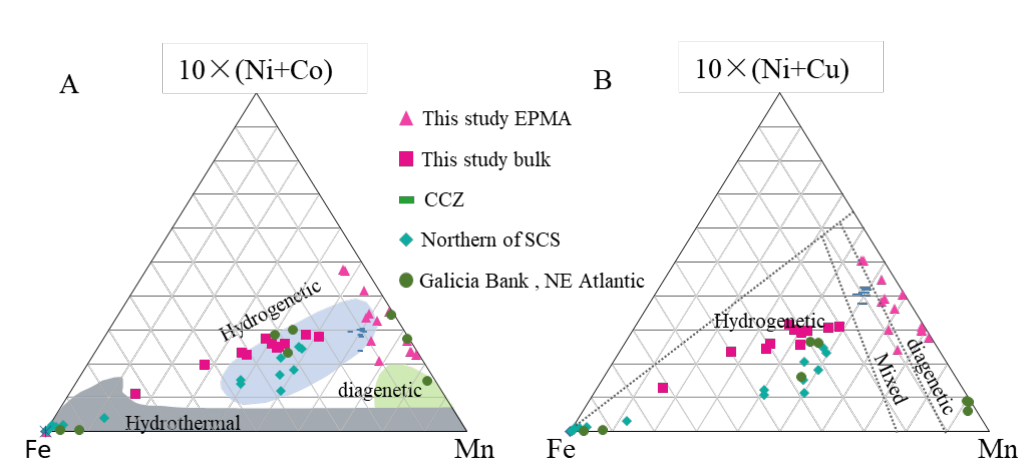
Figure 10. Ternary diagrams of the genetic determination of micro-manganese nodules from the Zhaoshu plateau. Other data were employed for comparison, including the Clarion and Clipperton Zone (CCZ) of the equatorial eastern Pacific [45]; the northern SCS [37]; and the Galicia Bank, Iberian margin, and northeastern Atlantic [66]. ( A ) Ternary diagram of Fe, Mn, and (Ni + Co) × 10; ( B ) ternary diagram of Fe, Mn and (Ni + Cu) × 10. All data in wt.%.